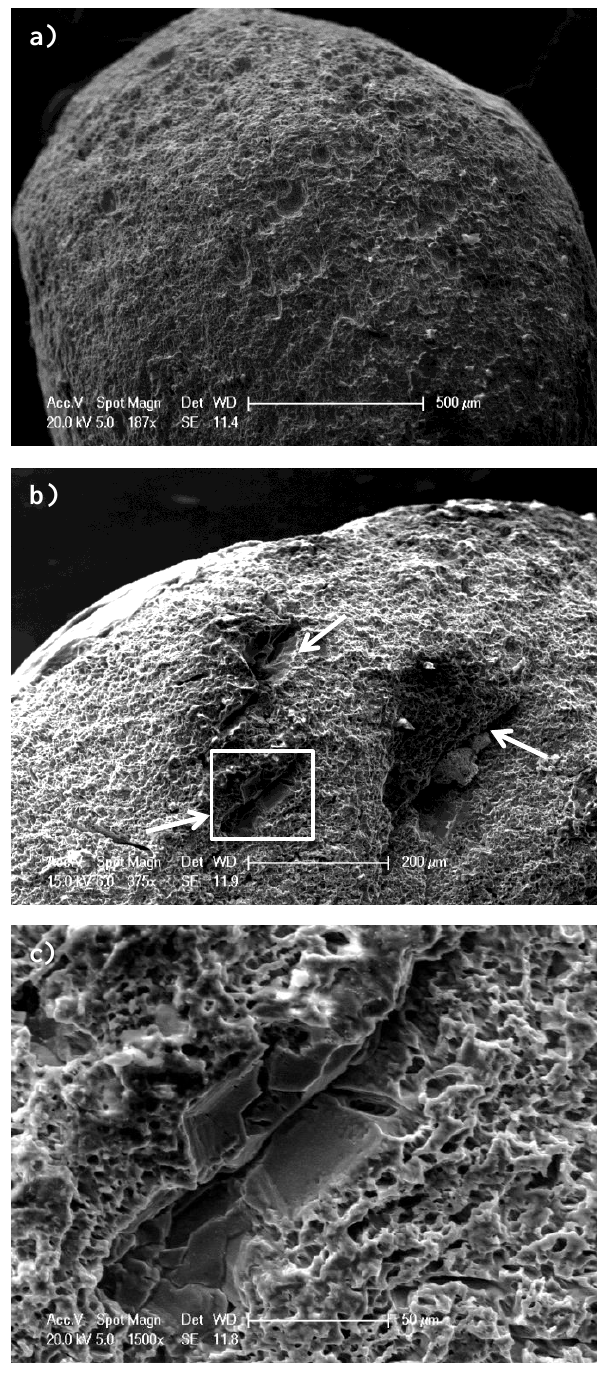
Figure 10. SEM imagery of olivine surfaces subjected to dissolu- tion by weak acids (see text). (a) Overall morphology of etched grain. (b) Detailed image of etched olivine surface; white arrows highlight etch pits. The white box shows the area represented by part (c) . (c) An etch pit developed on original surface of Igwisi Hills olivine; dissolution pit shape is strongly controlled by the crystallo- graphic structure of the olivine.